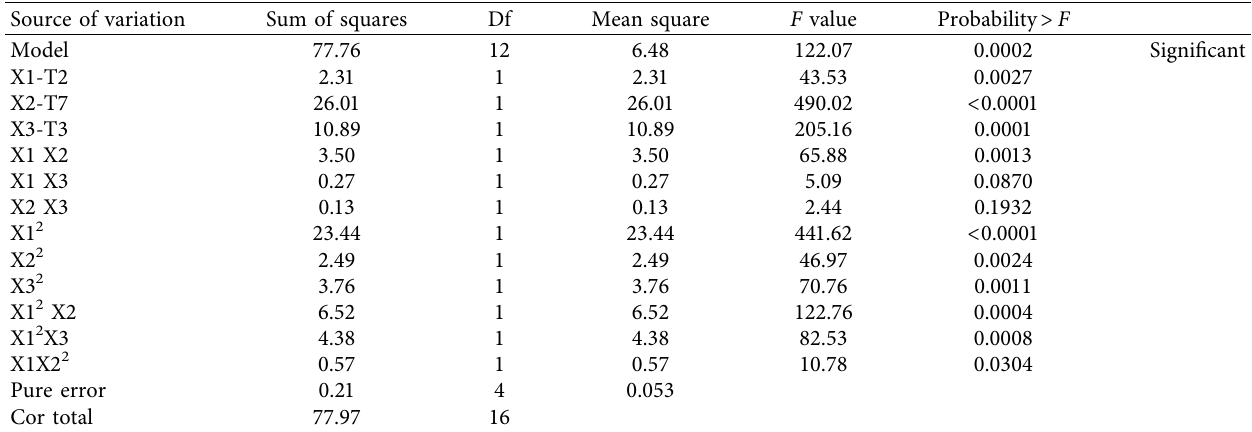
Table 7: ANOVA of quadratic polynomial model of B-BD